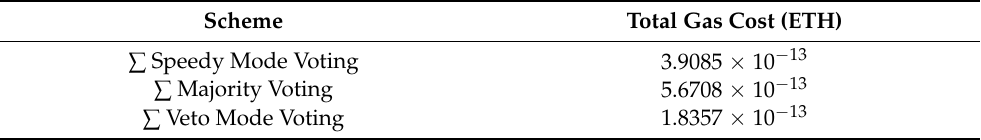
Table 7. Voting scheme gas